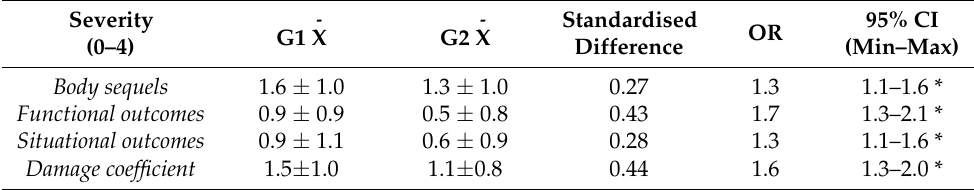
Table 4. The severity of permanent outcomes ( three-dimensional methodology ).